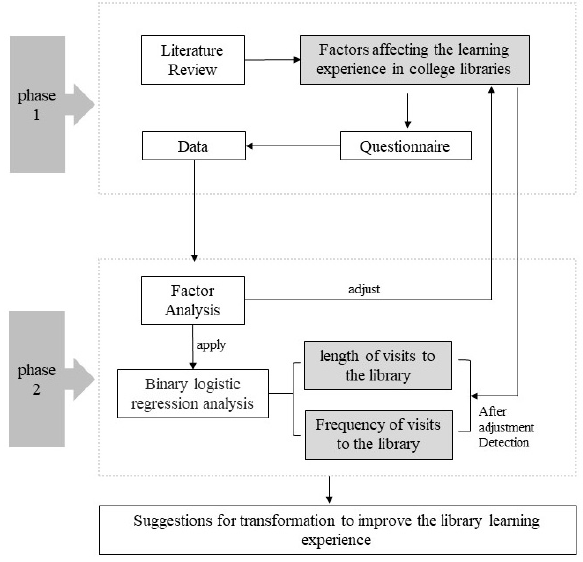
Figure 1. Research framework.